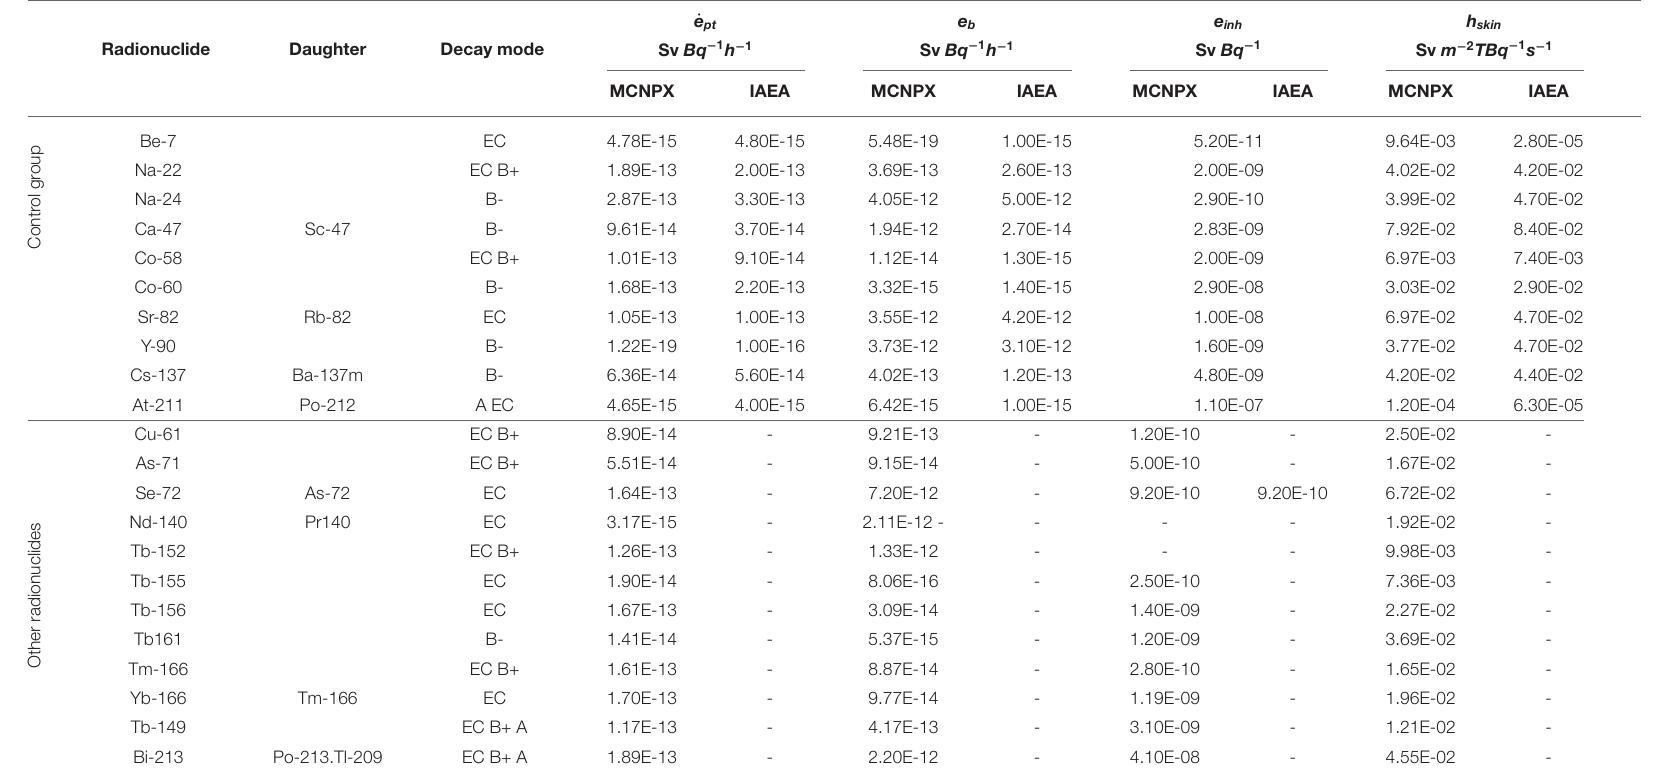
TABLE 4 | Results of the dose coefficients obtained with the Monte Carlo method.